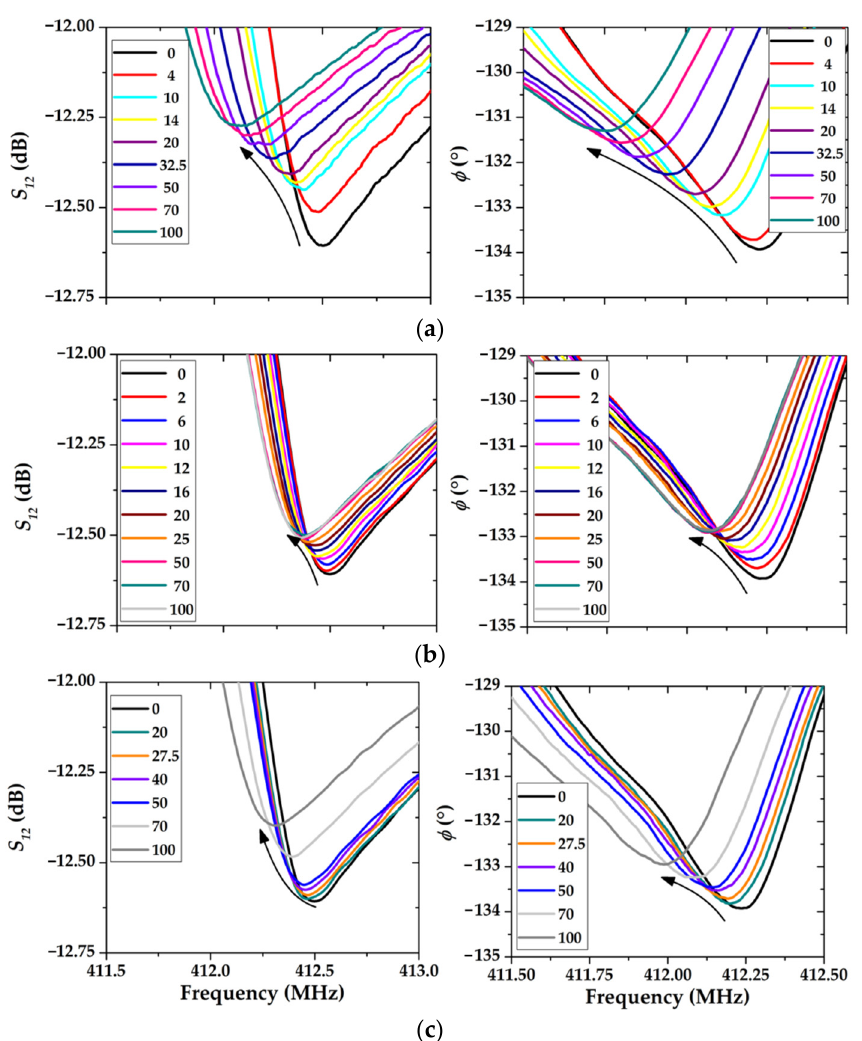
Figure 17. Frequency dependencies of the S 12 parameter and the phase φ of device #1 with LB consisting of 17 monolayers of AA-sensing layer film at different gas concentrations from 0 to 100%. ( a ) chloroform; ( b ) toluene; ( c ) ethanol.